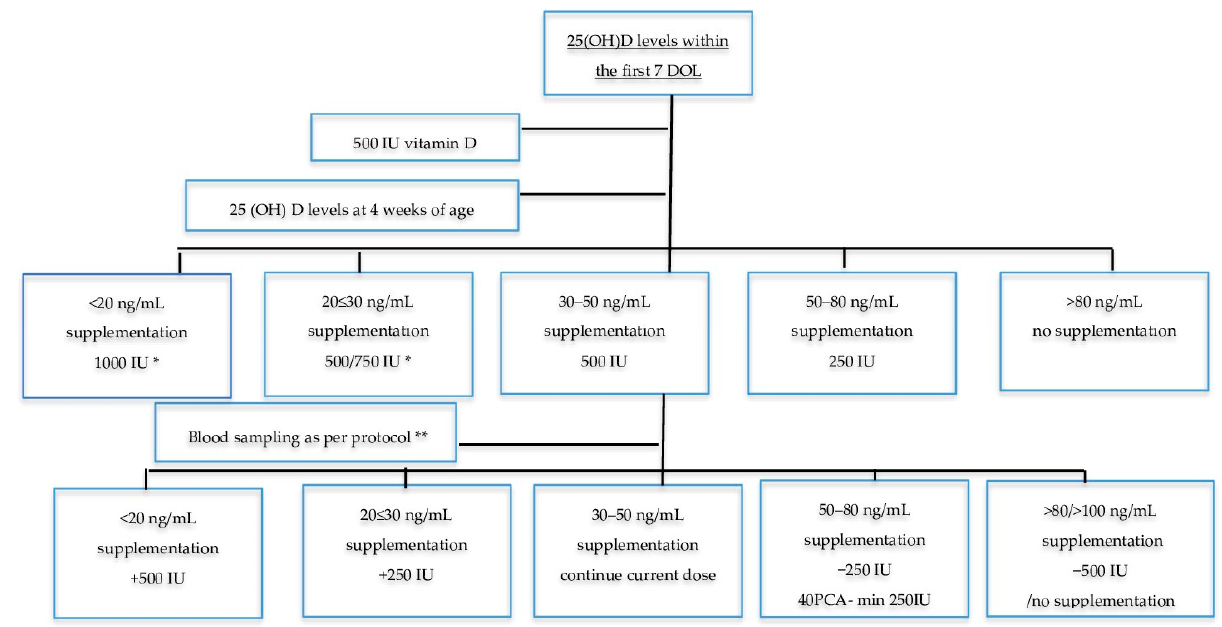
Figure 1. Monitored therapy schedule. DOL: days of life; PCA: post conceptional age; GA: gestational age; * 500 IU for infants < 1.5 kg, 750 IU for infants ≥ 1.5 kg; ** 8 weeks of age, 3 weeks for infants born < 26 GA, 35 weeks PCA ± 2 weeks, 40 ± 2 weeks PCA, 52 +/ − 2 weeks PCA.